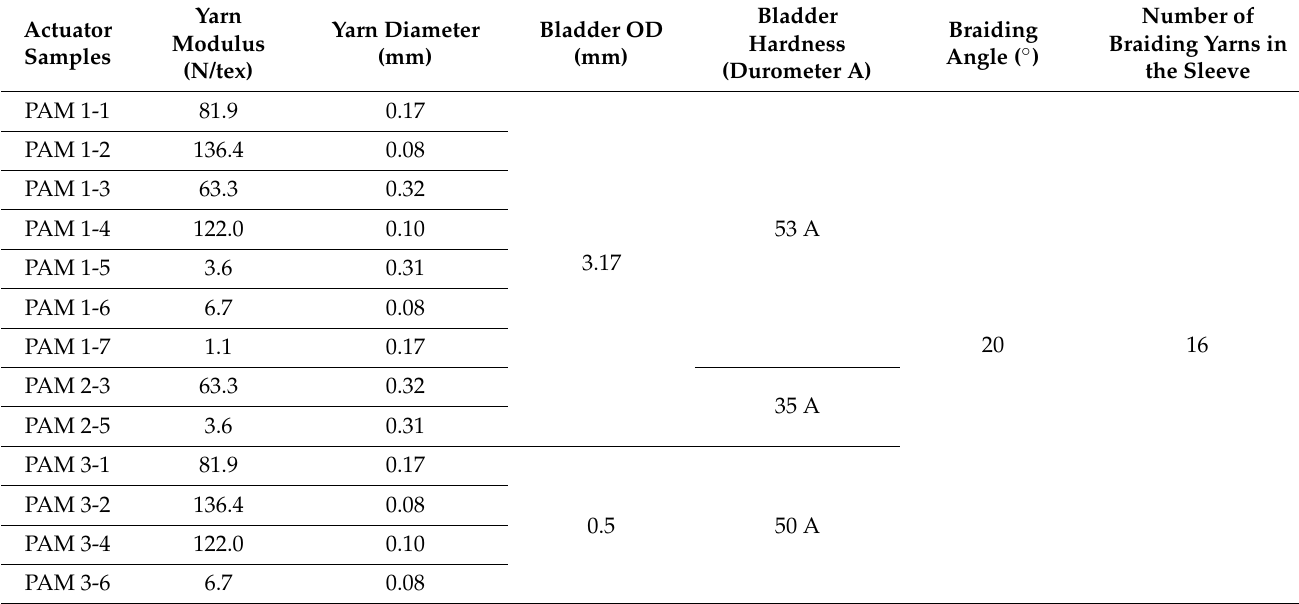
Table 3. Specifications of PAMs.